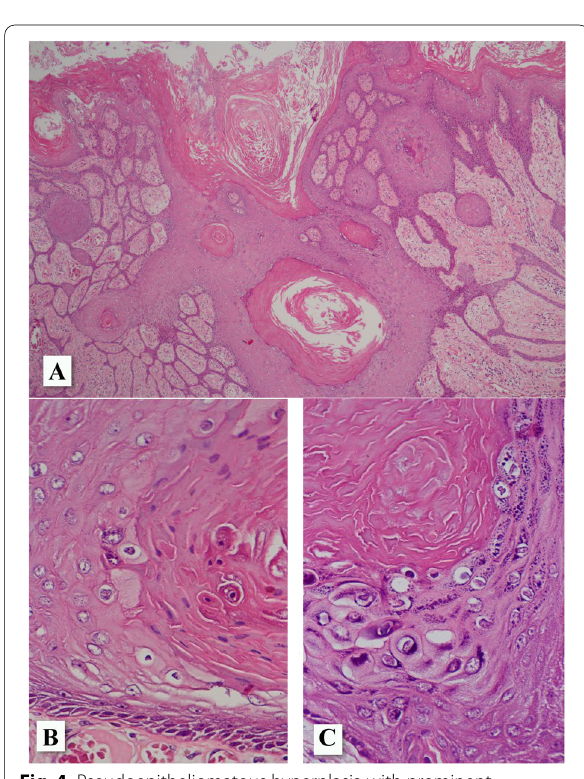
Fig. 4 Pseudoepitheliomatous hyperplasia with prominent anastomosing cords of elongated rete ridges (with a syringofibroadenoma silhouette) ( A : HE, 40x). Grains ( B : HE, 400x) and corps ronds ( C : HE,